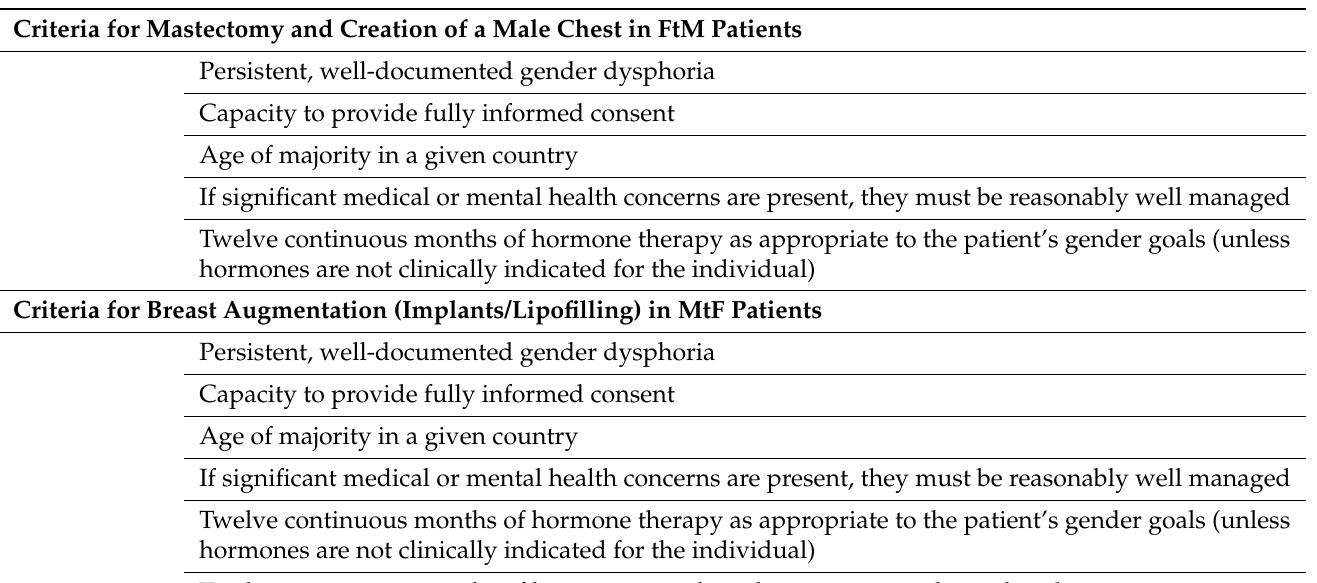
Table 4. Criteria for genital surgery (two referrals)